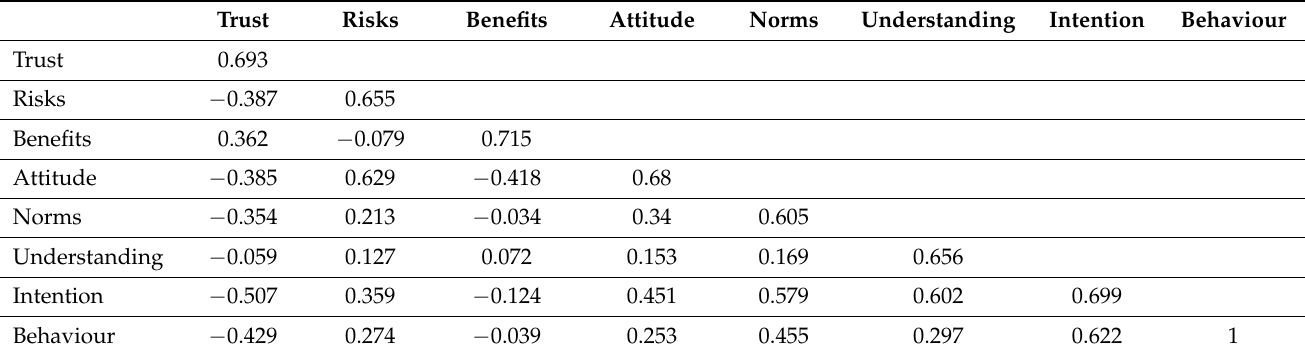
Table 3. AVE (diagonal) and latent variables